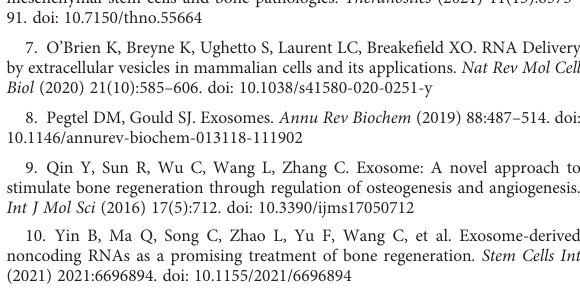
SUPPLEMENTARY TABLE 1 597 predicted target genes. The Canonical SMILES numbers of the 34 active chemical components were entered into the Swiss Target Prediction database (http://www.swisstargetprediction.ch/) and their potential action targets against Homo sapiens were predicted according to their chemical structures. SUPPLEMENTARY TABLE 2 354 genes in PI3K-Akt signaling pathway. All targets of PI3K-Akt signaling pathway were downloaded from the KEGG database (http://www. genome.jp/kegg/). A total of 354 pathway targets were obtained. SUPPLEMENTARY TABLE 3 62key targetsfor MQEFto exertanti-INFH through the PI3K-Aktsignaling pathway. The intersection of 354 targets in the PI3K-Akt pathway with597 targets in the MQEF were obtained by drawing Venn diagrams from the R package (Venn